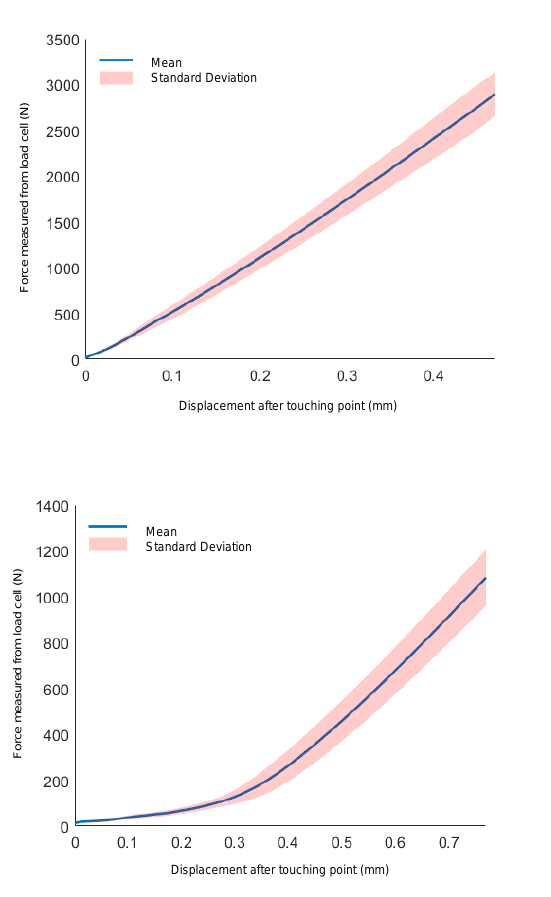
Figure 5: Force-displacement curves from running load test (Top) and downhill walking load test (Bottom).